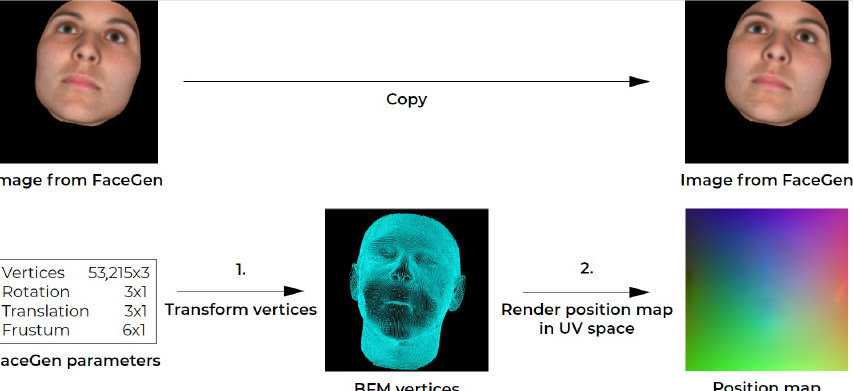
Figure 8. The FaceGen training data generation pipeline. A position map is generated for a facial image using the corresponding FaceGen parameters.